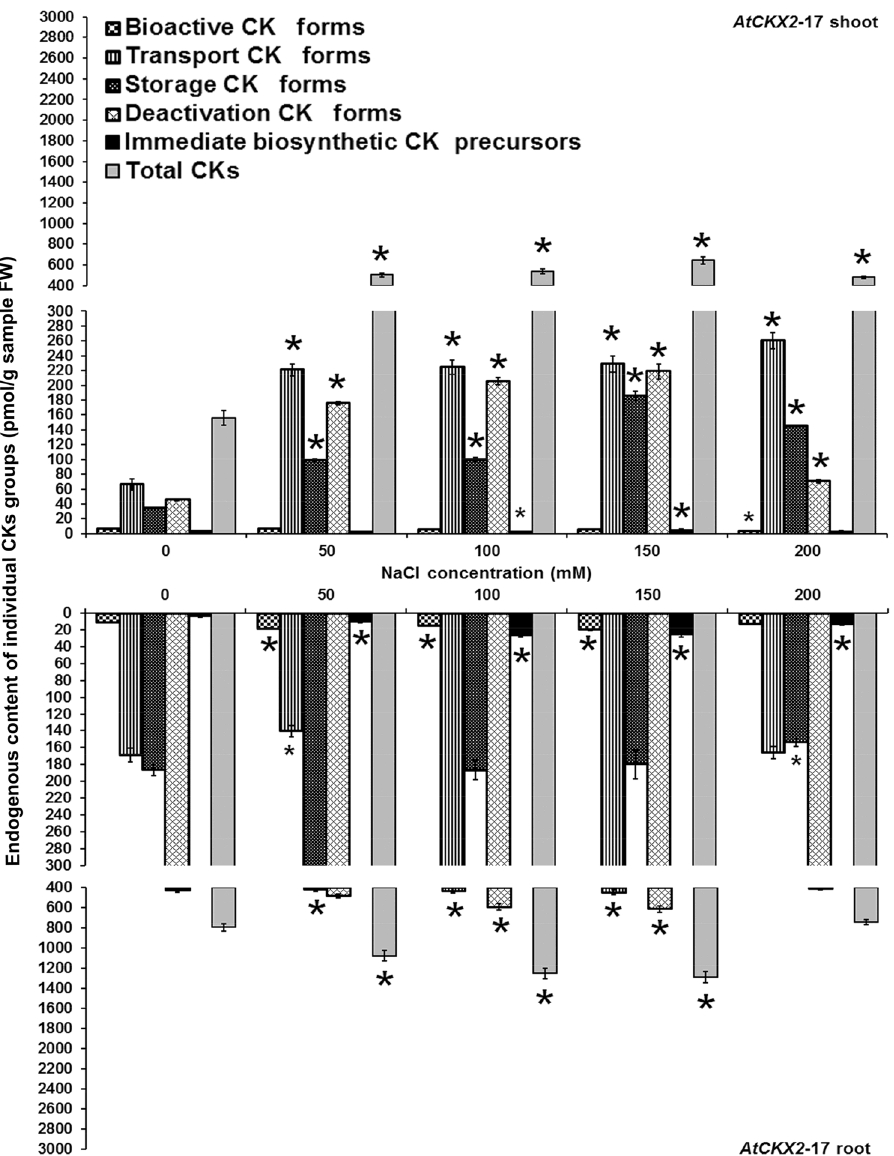
Figure 3. Endogenous cytokinin content in shoots and roots of 8-week-old AtCKX2 -17 transgenic Centaurium erythraea line. According to physiological function and conjugation status cytokinins were divided into five groups including bioactive forms (DHZ, iP, tZ , c Z), transport forms (DHZ9R, iP9R, t Z9R, c Z9R), storage forms (DHZ9ROG, DHZOG, t Z9ROG, t ZOG, c Z9ROG, c ZOG), deactivation forms (DHZ7G, DHZ9G, iP7G, iP9G, t Z7G, t Z9G, c Z7G, c Z9G), immediate biosynthetic precursors ( t ZRMP, DHZRMP, c ZRMP, iPRMP) and total CKs content (boja kolone). Data represent mean ± standard error. Means marked with asterisks are significantly different from corresponding control values (LSD test, p ≤ 0.05). The bigger asterisks represent the values significantly higher than control ones while smaller asterisks represent values significantly lower than control